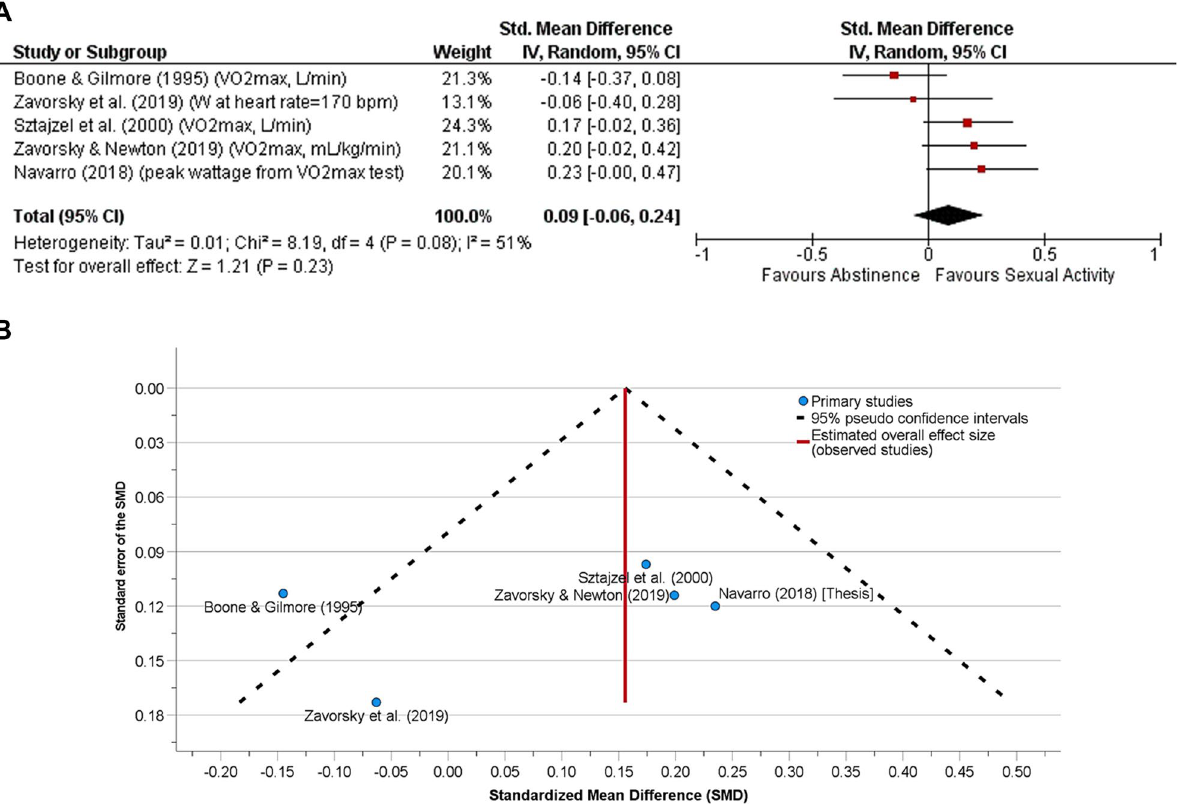
Figure 1. (A) The effect of sexual activity that occurred 30 min to 12 h before an aerobic fitness assessment is displayed using a Forest Plot. The data demonstrate that aerobic capacity (aerobic fitness) is unlikely affected by prior sexual activity or abstinence. That is, both experimental and control conditions provide similar test results. A random-effects model was used. No other adjustments were made here. There was moderate heterogeneity between studies ( p = 0.08). (B) Funnel plot for the detection of publication bias in ( A ). Egger’s random effects meta-regression-based test was used with the Knapp-Hartung SE adjustment. There was no funnel plot asymmetry (Intercept = 0.40, SE = 0.43, t = 0.93, p = 0.42, 95% CI of the coefficient = − 0.97 to 1.76); Standard error of the effect size = − 2.57, SE = 3.54, t = − 0.73, p = 0.52, 95% CI − 13.84 to 8.69). After adjusting for the missing studies, the SMD (SE of the SMD) was 0.16 (0.09) [95% CI − 0.08 to 0.39, p = 0.15], demonstrating that neither abstinence nor sexual activity prior to exercise affects aerobic fitness